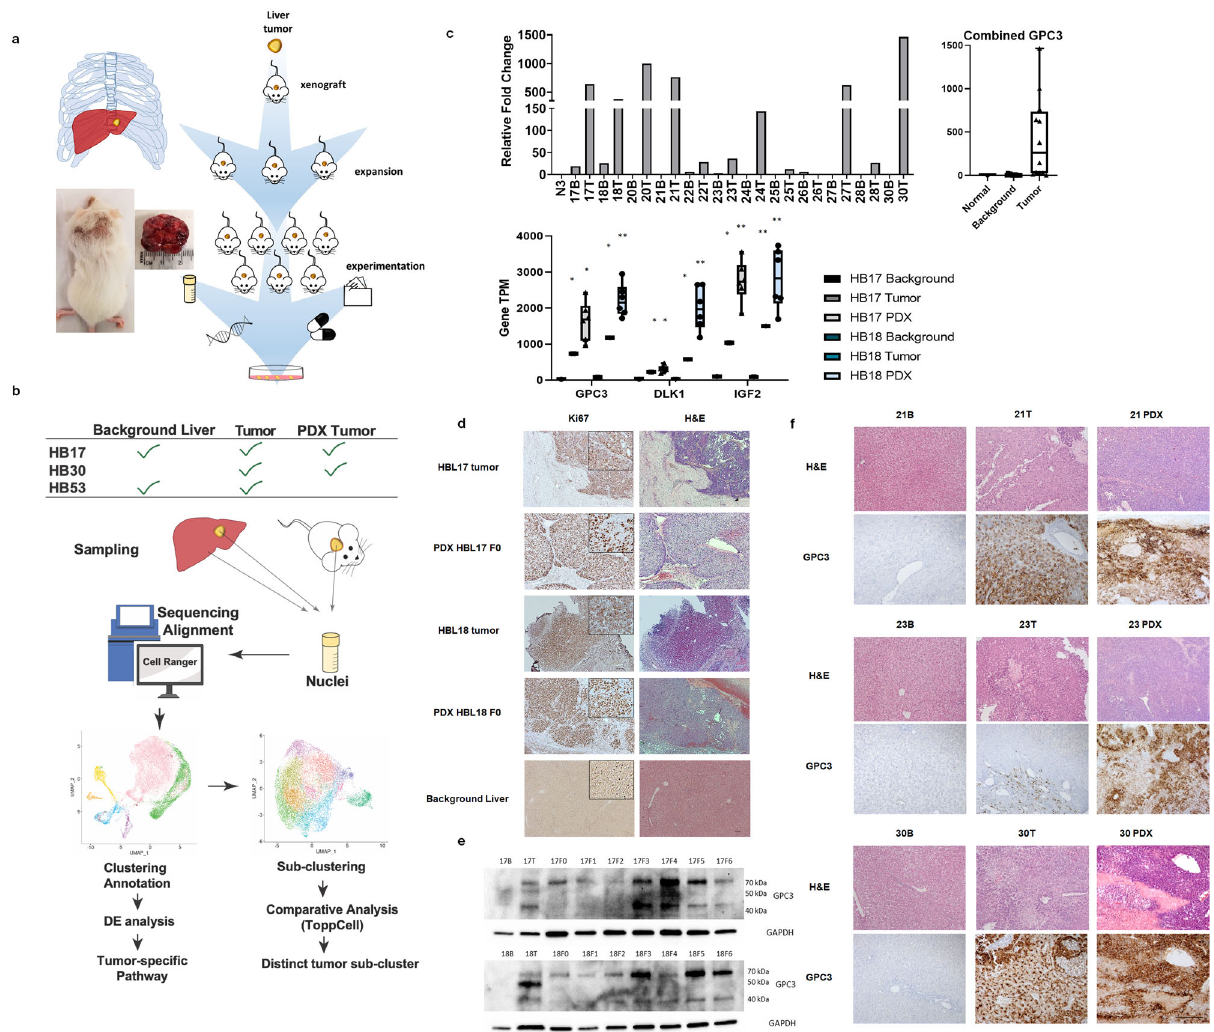
Fig. 1 Comparison of HB background liver to tumor and PDX. a Schematic of PDX model. Diagram showing the process of implantation of tumor, growth, and experimentation, including cryopreservation, molecular analysis, generation of cell lines, drug testing, and database of effective treatments. Mouse image demonstrates successful heterotopic tumor implantation with tumor growth. b Method and analysis work fl ow. Diagram of samples used for scRNAseq, and data analysis work fl ow through tumor sub-clustering (computer monitor image is a stock image from Biorender). c Real time PCR validation of GPC3 gene expression of human HB background liver (B) and tumor (T) compared with control liver (N) (control liver = nontumor liver) (statistical analysis (student t -test) was performed on averaged data for N, B, and T samples, p < 0.05 for T vs N and T vs B. Each bar represents one patient sample). Raw gene transcript (TPM) values in background liver, HB tumor and PDX tumor showing increased expression of GPC3 in tumor and PDX tumors (average of PDX ’ s passage F0 – F5) statistical signi fi cance determined by student t -test (SEM, * p < 0.05, ** p < 0.005 relative to background of the same patient). TPM — transcripts per million. d PDX-HB17 and 18. Histology of primary tumor and PDX tumor (F0) of HB17 and HB18 and representative background liver (HB30) showing proliferation by H&E and KI67 (ma5-14520) (4x objective, scale bar 10 µ M with zoomed-in 10 × 751 inlay, magni fi ed 3x in KI67 panel). e . Western blot comparing GPC3 (ab207080) protein expression in B and T to PDX passages (passages = F0 – F6). Tumor and PDX samples have elevated full-length, HS side, chain and cleaved N-terminal GPC3 fragments (the antibody does not detect C terminus). f Histology of background liver, primary tumor and PDX tumor of HB21, 23, and 30 showing maintenance of histologic features and proliferation by H&E, as well as increased GPC3 expression in tumor and even greater expression observed in PDX tumor (10x, scale bar 50 µ